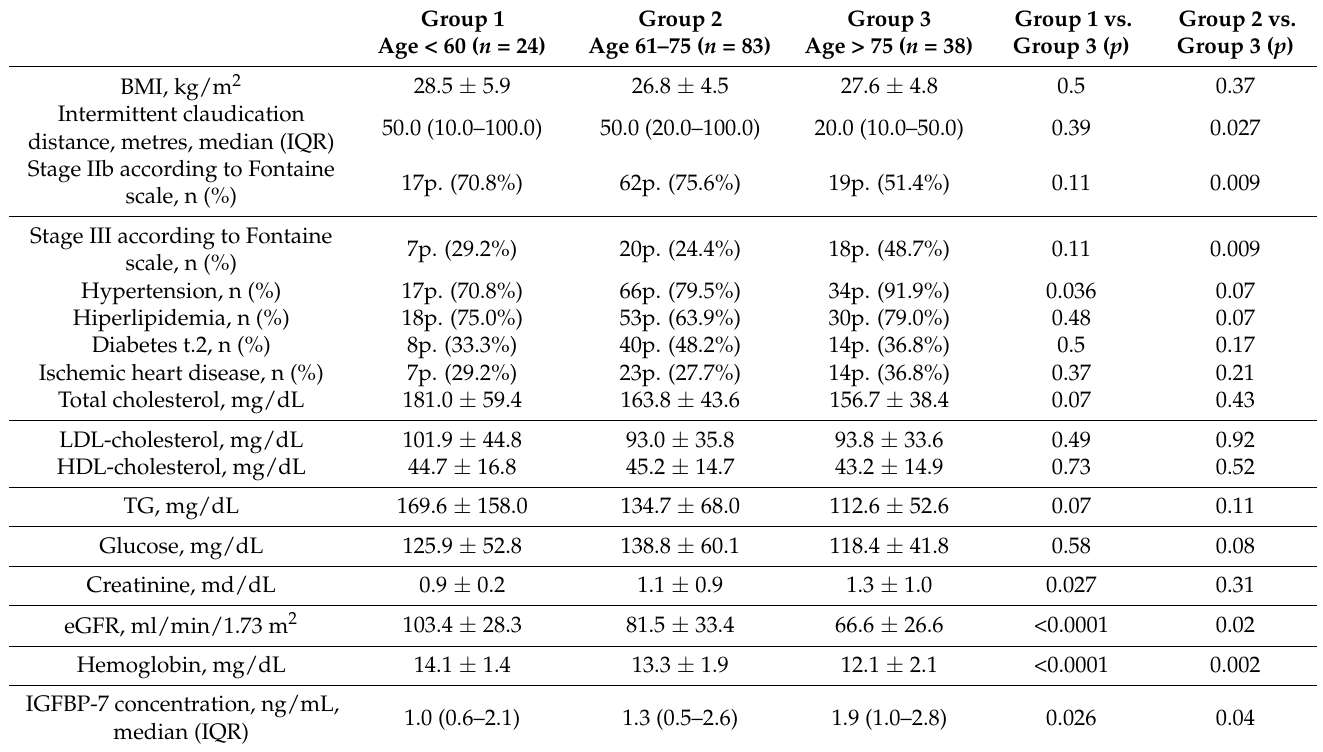
Table 4. Comparison between age